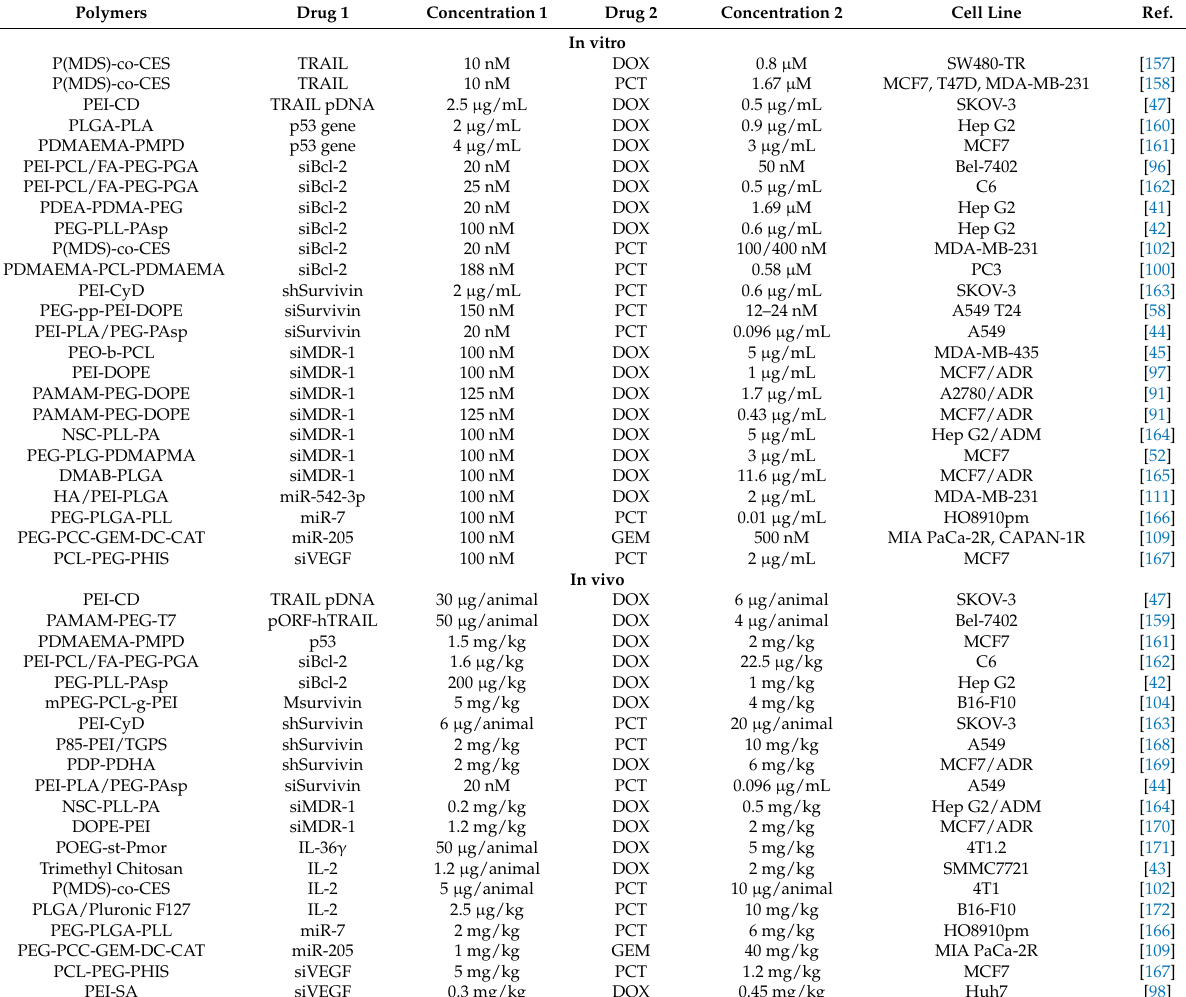
Table 3. Combinations of nucleic acids therapeutics and chemotherapeutics delivered in polymeric co-delivery systems.